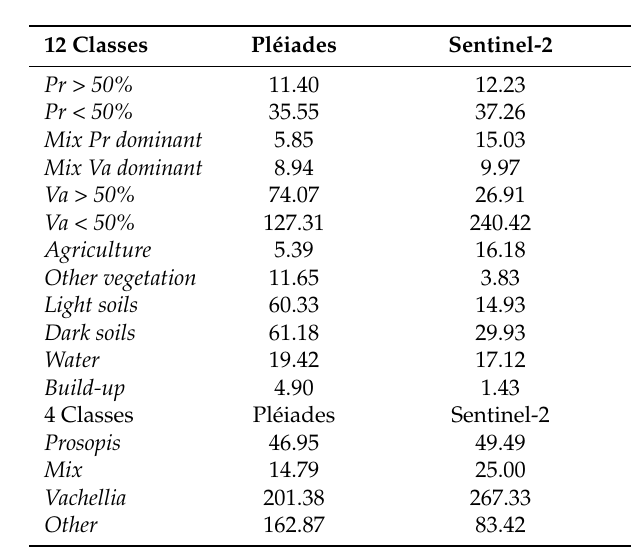
Table 6. Individual class coverage in km 2 for Pléiades (2015) and Sentinel-2 (2016) datasets: (Top) results for the original (12 class) classification; and (Bottom) results after the re-classification into four broader classes.